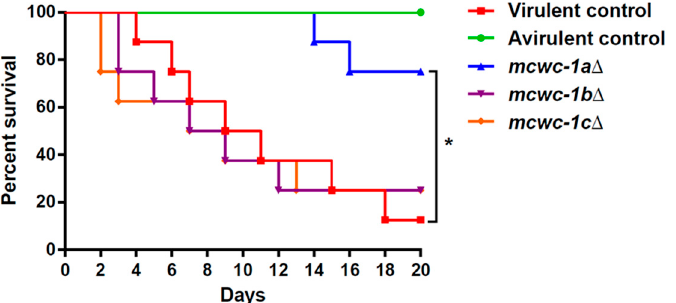
Figure 1. The gene mcwc-1a is essential to maintain the virulence potential. Virulence assays in immunosuppressed mice injected with 1 × 10 6 spores of the mutants in the three wc-1 genes of M. lusitanicus : mcwc- 1a Δ (blue), mcwc- 1b Δ (purple), and mcwc- 1c Δ (orange). In addition, two control strains were also injected: the virulent wild-type strain R7B (red) and the avirulent wild-type strain NRRL3631 (green). The survival rate of the mutant was compared to the virulent control strain and statistically analyzed by a Mantel–Cox test (*, p -value = 0.006).